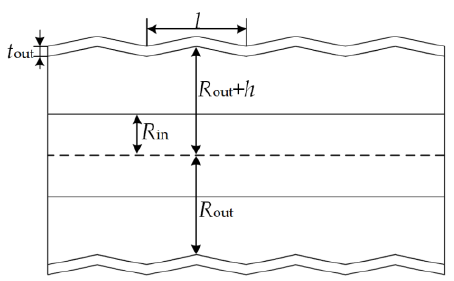
Figure 1. Oblique diagram of a section of the phase stable cable with a corrugated outer conductor.